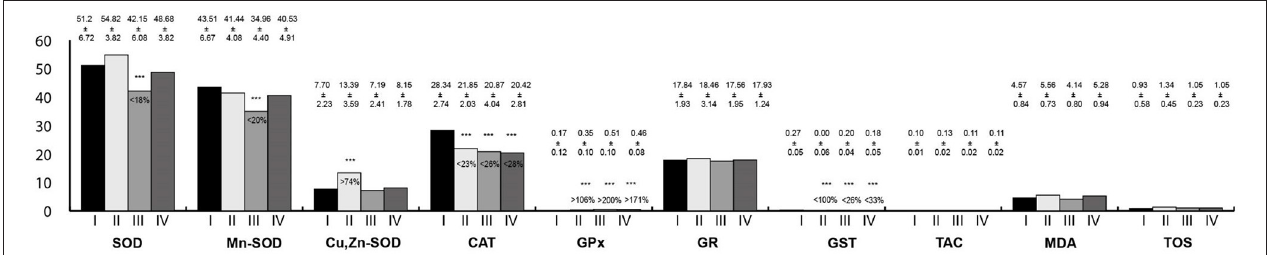
FIGURE 1 | Oxidative stress parameters in the tongue homogenates. I, control group; II, group exposed to LF-EMFs; III, group exposed to RF-RMF; IV, group exposed simultaneously to LF-EMFs and RF-EMFs; SOD, superoxide dismutase (NU/mg protein); Mn-SOD, manganese-dependent superoxide dismutase (NU/mg protein); Cu,Zn-SOD, copper- and zinc-dependent superoxide dismutase (NU/mg protein); CAT, catalase (IU/g protein); GPx, glutathione peroxidase (IU/g protein); GR, glutathione reductase (IU/g protein); GST, glutathione S-transferase (IU/g protein); TAC, total antioxidant capacity (mmol/g protein); MDA, malondialdehyde ( µ mol/g protein); TOS, total oxidative status.